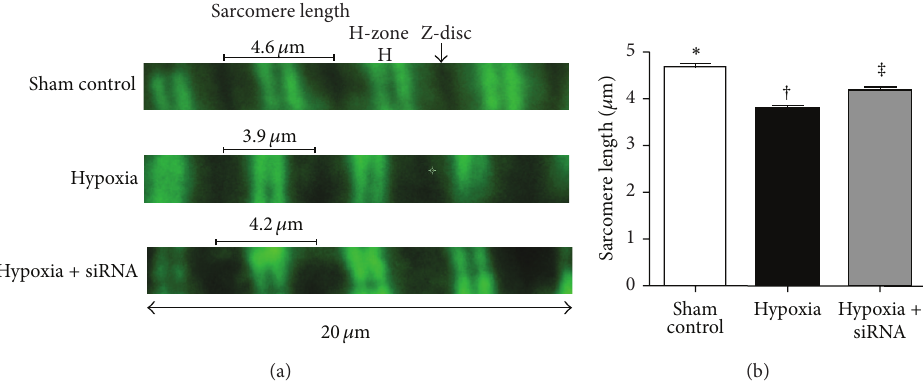
Figure 6: Changes in length of sarcomere in right ventricular myocytes after immunofluorescent (IF) staining by day 28 after pulmonary arterial hypertension (PAH) ( 𝑛 = 10 ). (a) Changes in length of sarcomere identified by troponin-I staining in the three groups (1000x). (b) ∗ versus other groups with different symbols ( ∗ , † , ‡ ), 𝑃 < 0.001 . Statistical analysis using one-way ANOVA, followed by Bonferroni multiple comparison post hoc test. Symbols ( ∗ , † , ‡ ) indicate significance (at 0.05